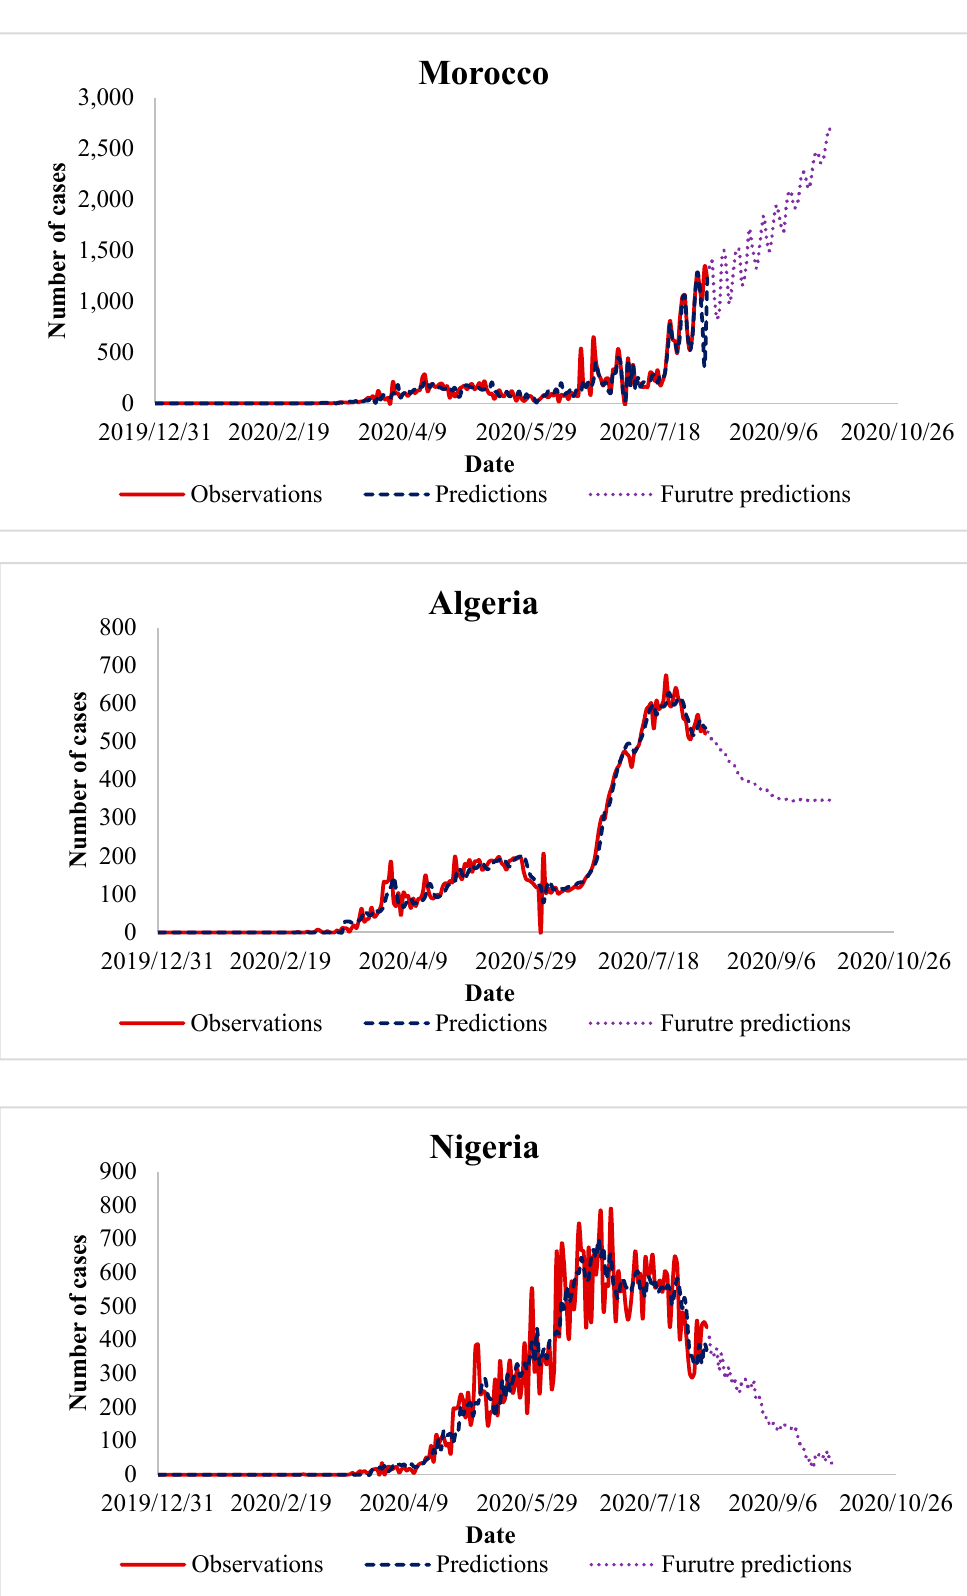
Figure 8. Future prediction of COVID-19 cases in African countries.